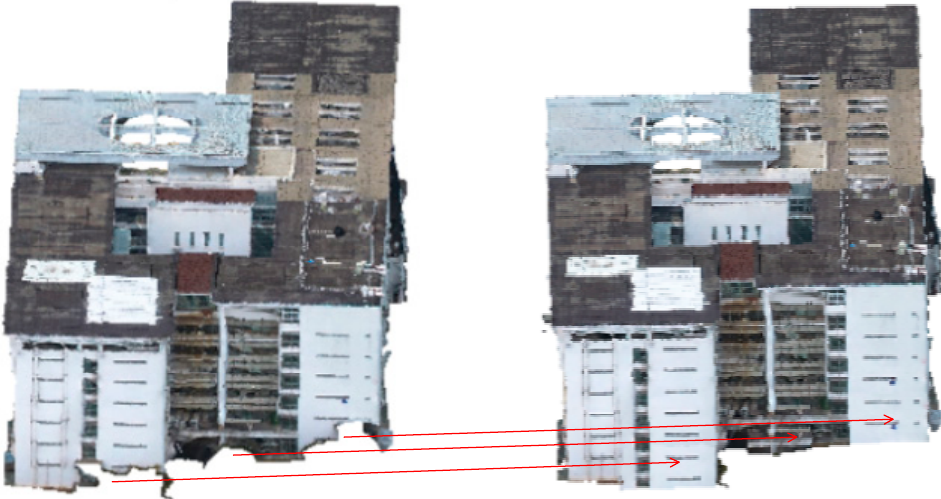
Figure 10. Repaired results of lateral holes (red lines represent the corresponding areas).